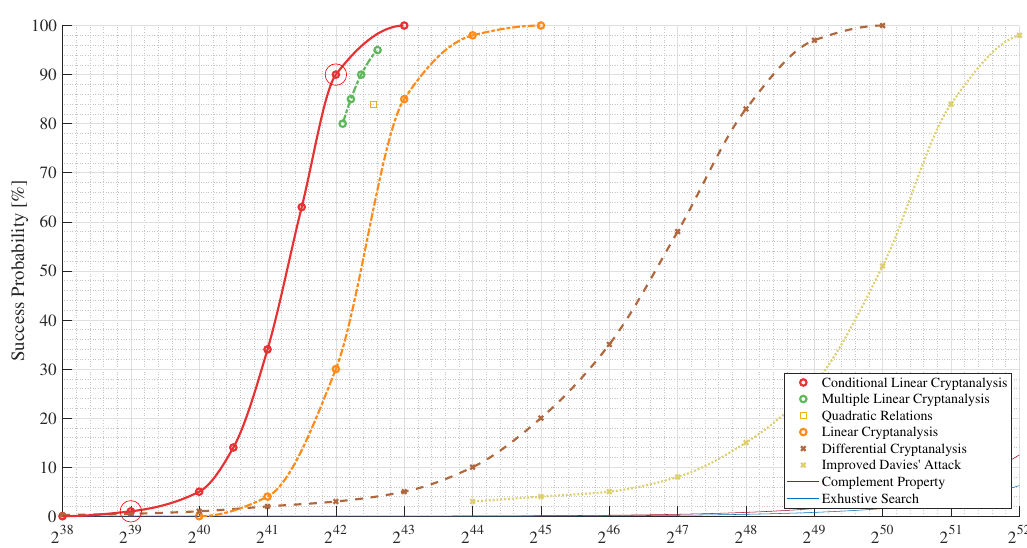
Figure 14: Comparison of the Success Probability by Complexity of the Attack (The marked points were experimentally verified on 79 runs of our attack on the full 16-round